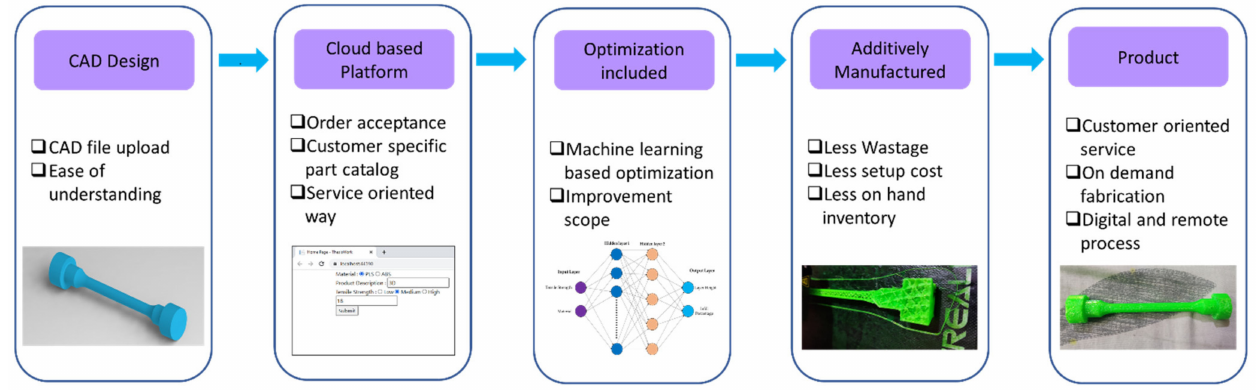
Figure 10. Features of the proposed cloud-based additive manufacturing platform.